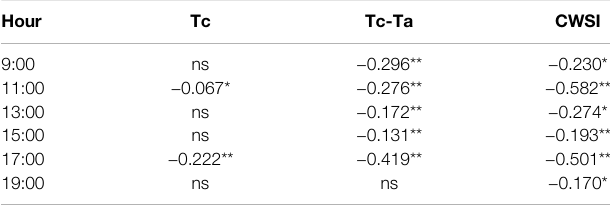
TABLE3| Pearson ’ scorrelationcoef fi cientsbetweenthermalparametersandthe transpiration. All values come from readings of the CK treatment. Hour